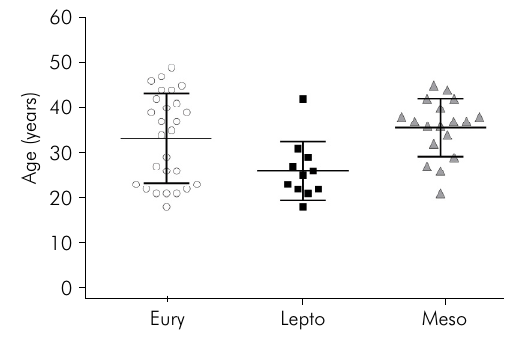
Figure 5. Means and standard error of TMD patient ages, according to facial type. Different letters indicate a statistical difference (ANOVA, Tukey’s test, p < 0.05).